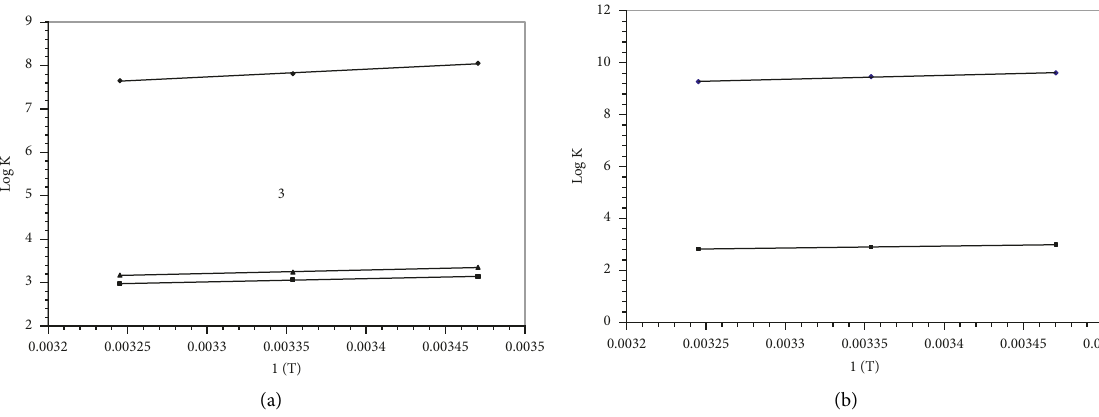
Figure 6: (a) Effect of temperature on the protonation constant of TSC1. (b) Effect of temperature on the formation constant of the Cd (II)- TSC1 complexes.